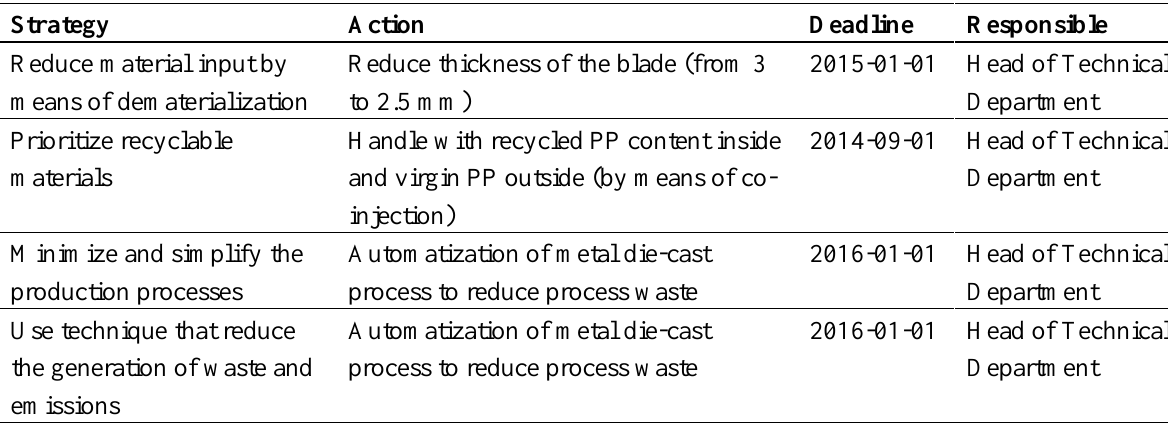
Table 4. Action plan.